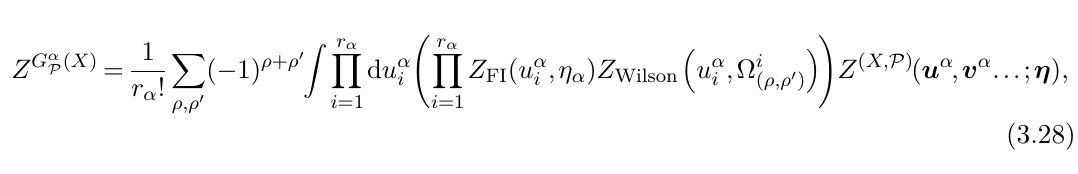
( X ) for a linear quiver gauge theory X P